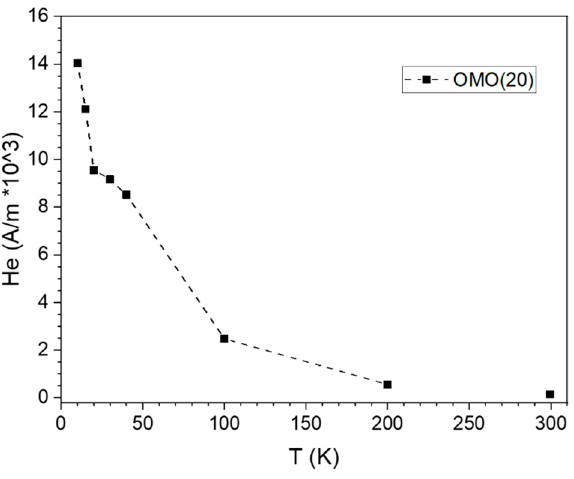
Figure 11. Exchange bias field of OMO(20) as a function of temperature, where the dotted line represents the general trend.